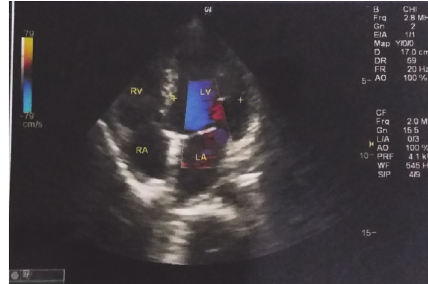
Figure 2: Echocardiography of the patient.